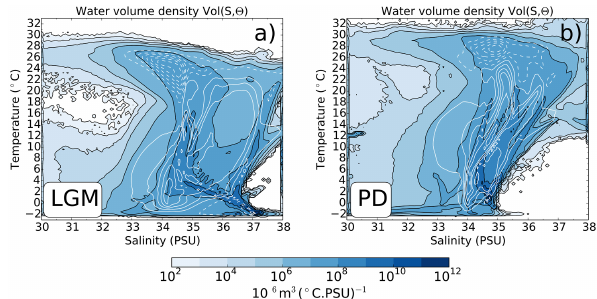
Figure 8. Sea-water volume density distribution projected in the temperature–salinity diagram for (a) the LGM simulation and (b) the PD simulation. The LGM and PD thermohaline streamfunc- tions are superimposed. The contour interval for the volume den- sity is 10 6 m − 3 ( ◦ CPSU) − 1 . The volume density at S = 30PSU and S = 38PSU includes volume density of water with S ≤ 30PSU and S ≥ 38PSU, respectively.